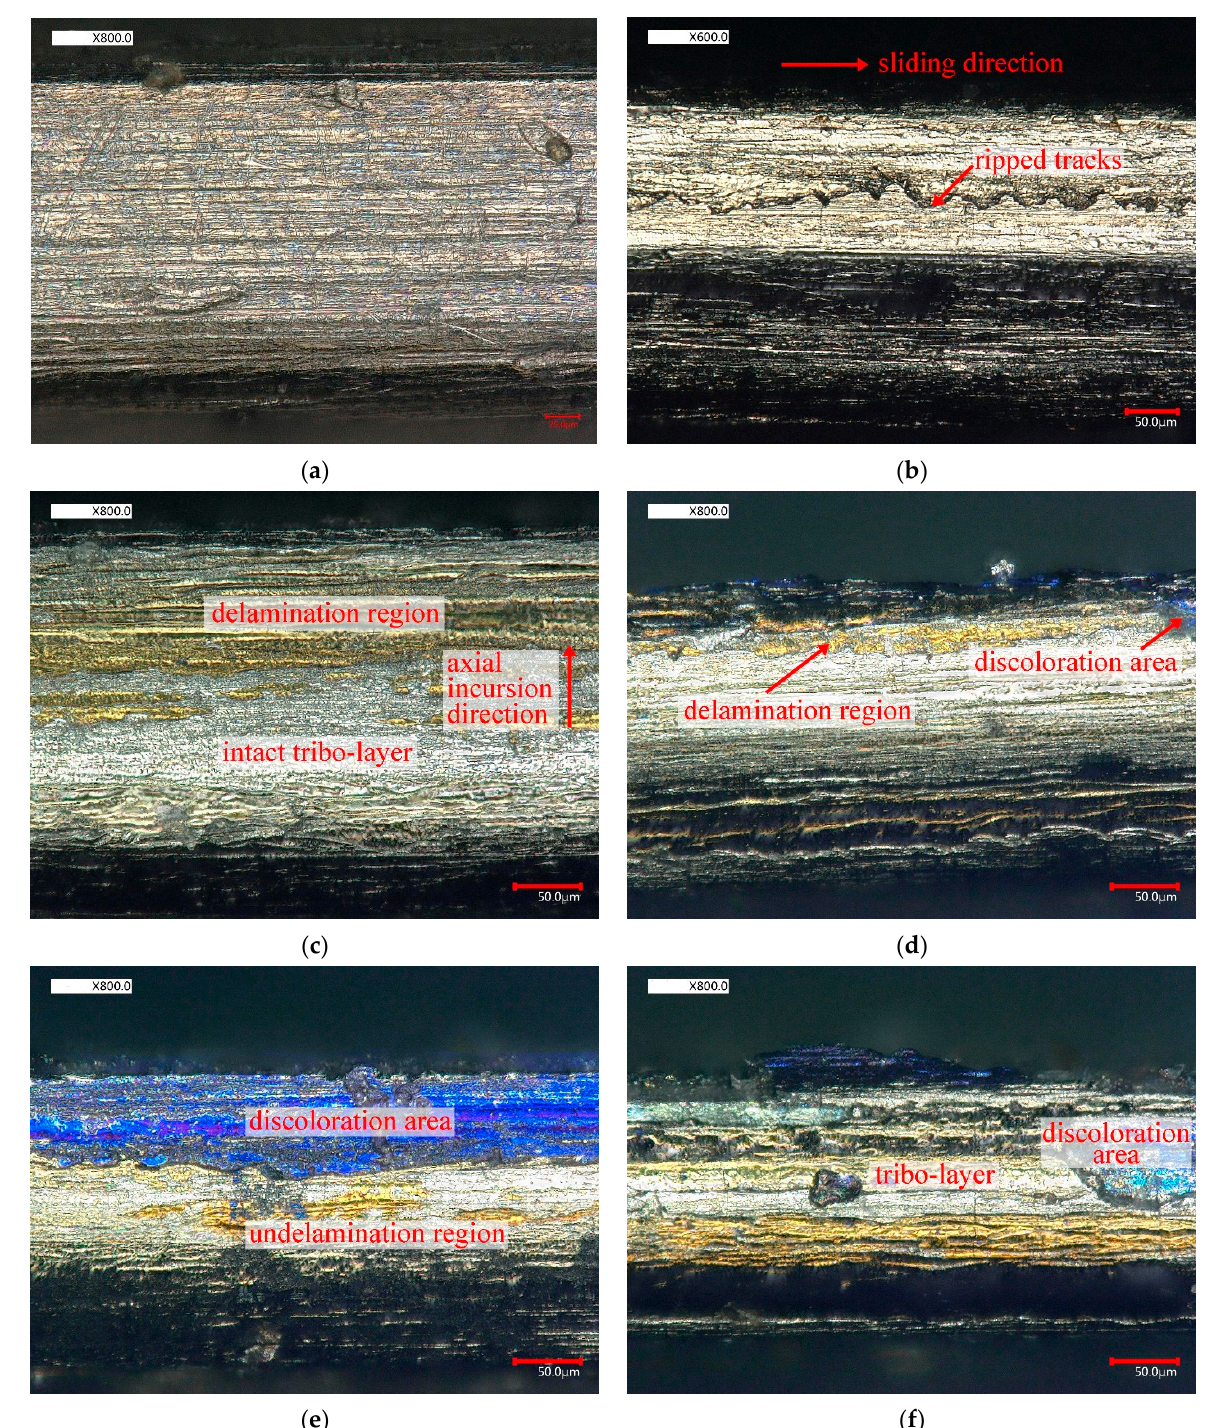
Figure 10. The worn morphology of the seal fin observed by ultra-depth-of-field microscope. ( a ) the original seal fin; ( b ) only radial rub; ( c ) 60 μ m/s; ( d ) 80 μ m/s; ( e ) 100 μ m/s; ( f ) 120 μ m/s.